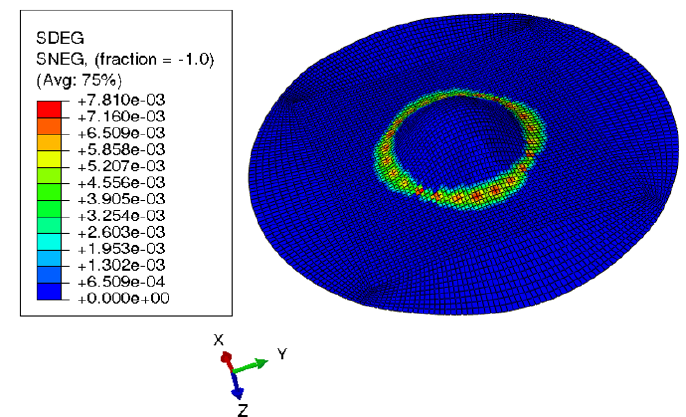
Figure 16. 3D iso-values of stiffness degradation determined by finite-element simulation for pre- forming process.